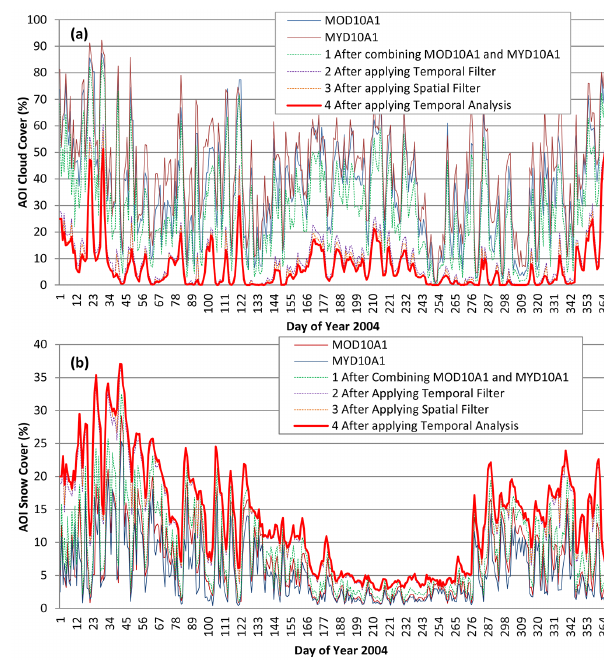
Figure 6. (a) Cloud coverage from the MODIS Terra (MOD10A1), Aqua (MYD10A1) and after each step of the cloud removal Tech- nique for the validation period of year 2004. MOD10A1 and MYD10A1 are original cloud cover estimates from MODIS Terra and Aqua, respectively, while steps 1–4 indicate the cloud cover es- timates after combining both Terra and Aqua products, and after applying the temporal filling, spatial filling and temporal analysis, respectively. (b) Same as Fig.6a, but for snow cover estimates.